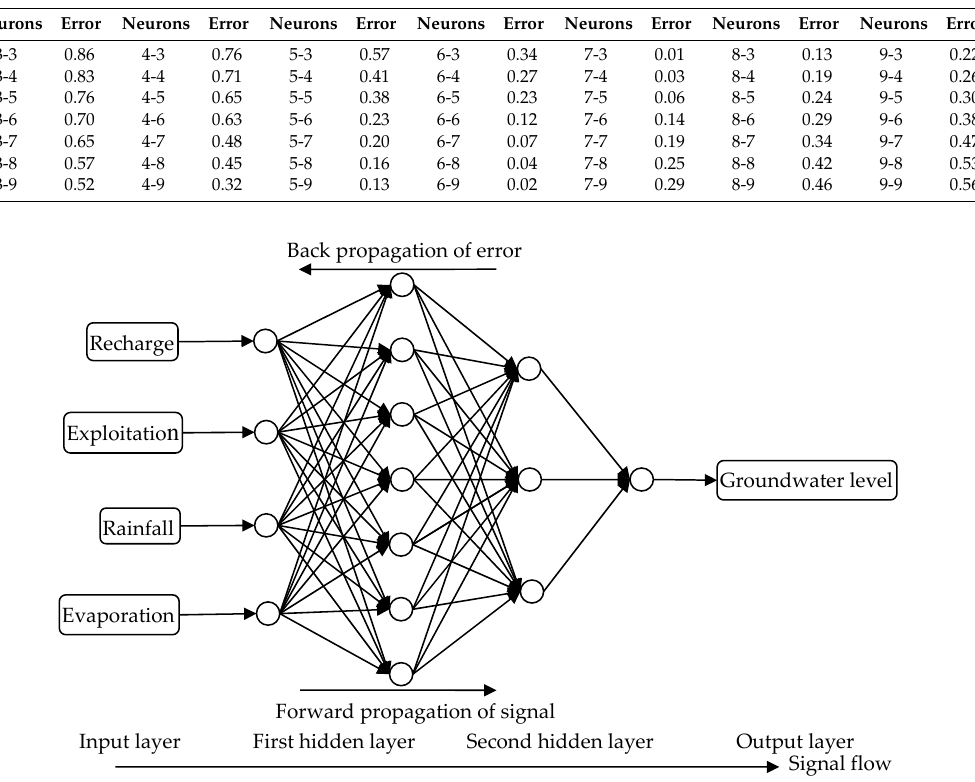
Figure 2. Topology chart of the BP neural network with double hidden layers.